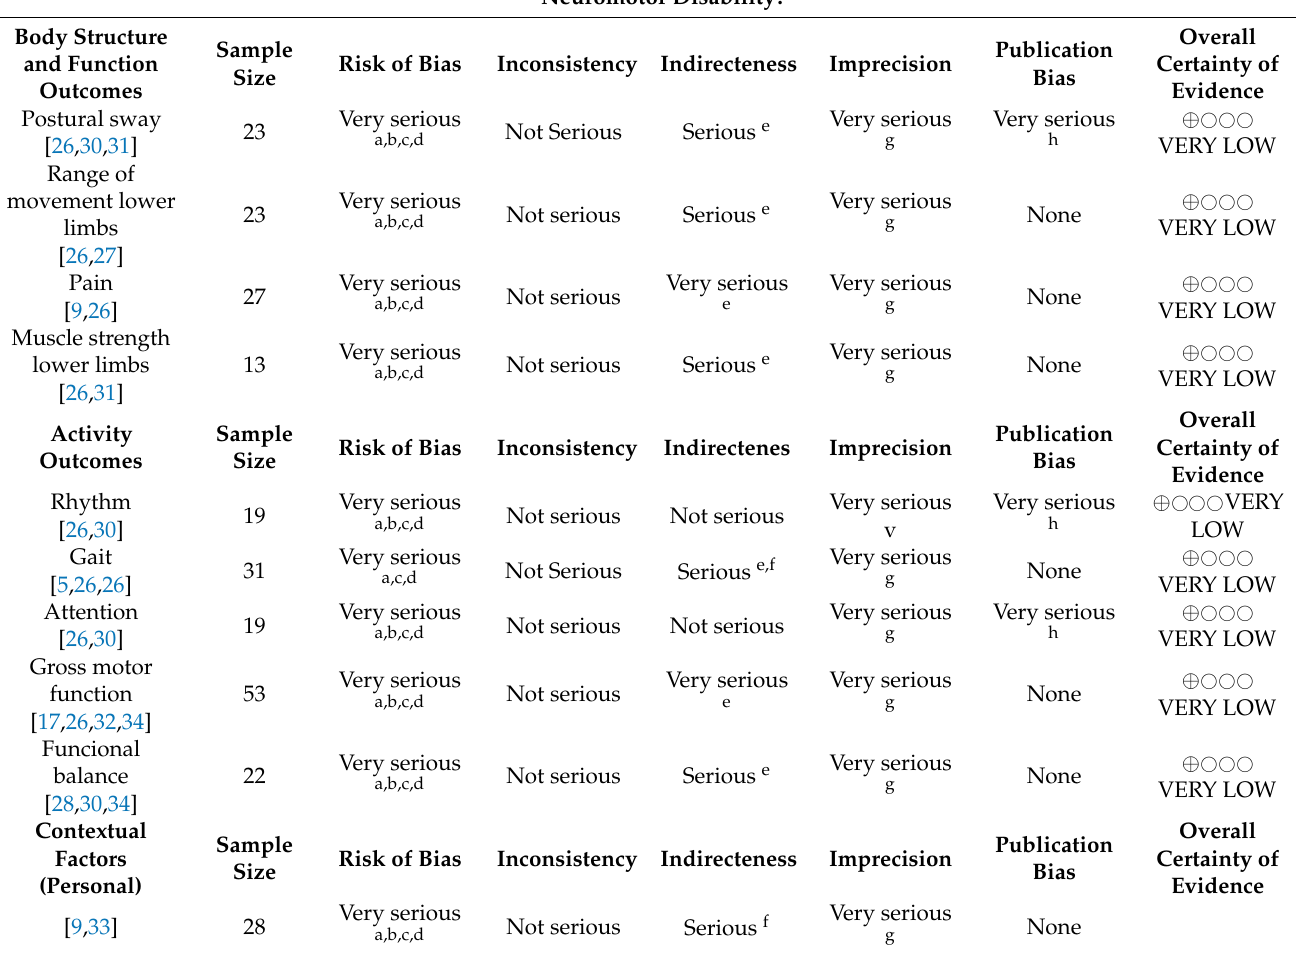
Table 5. Evidence synthesis